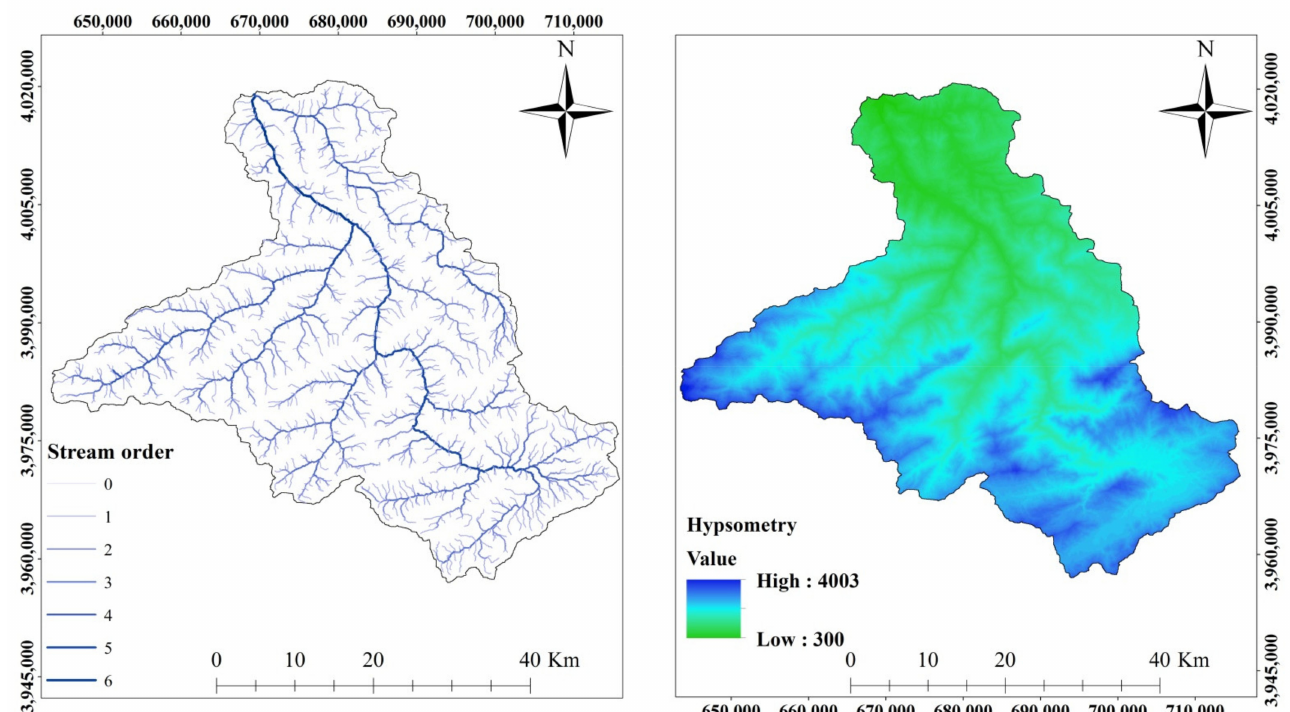
Figure 3. Stream order and hypsometry maps of the Talar